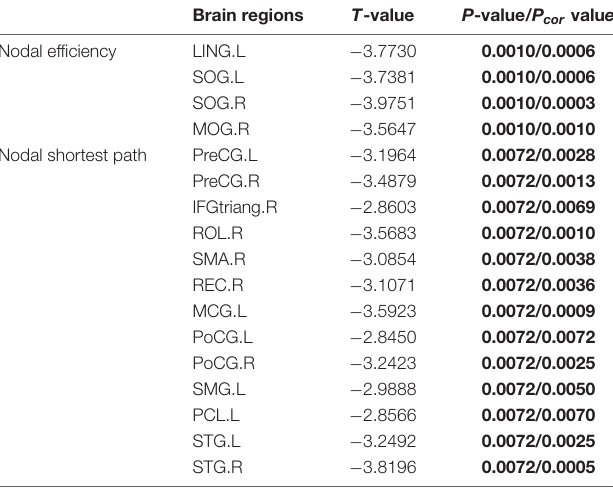
TABLE 2 | Regions showing disrupted nodal characteristics in patients with RBD compared with